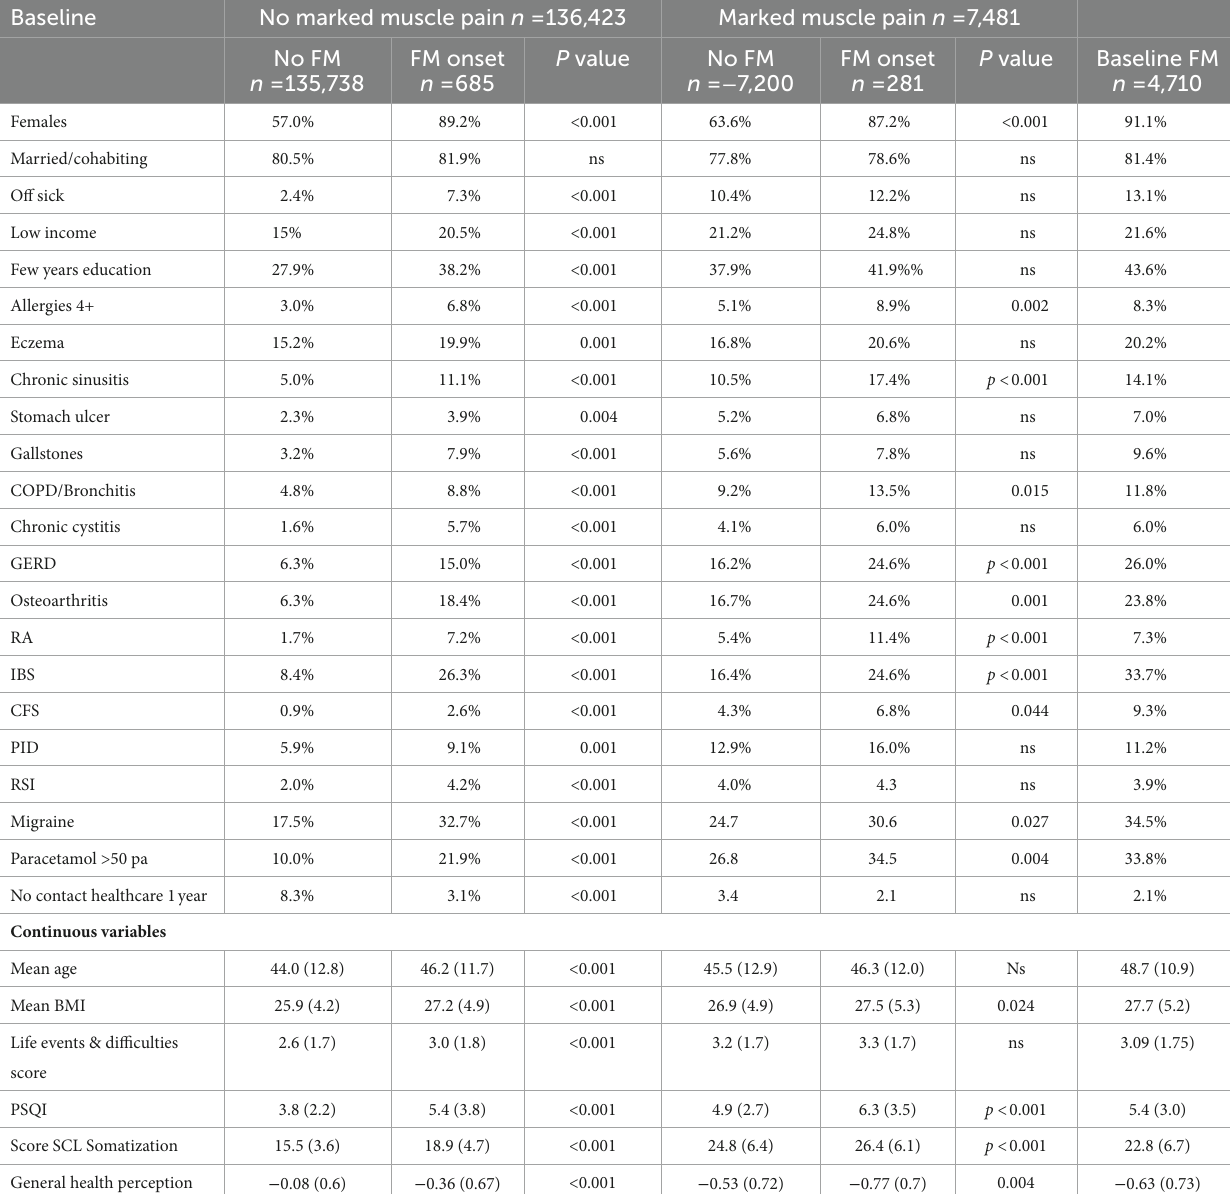
TABLE 1 Potential predictors of self-rated fibromyalgia onset by baseline muscle pain.